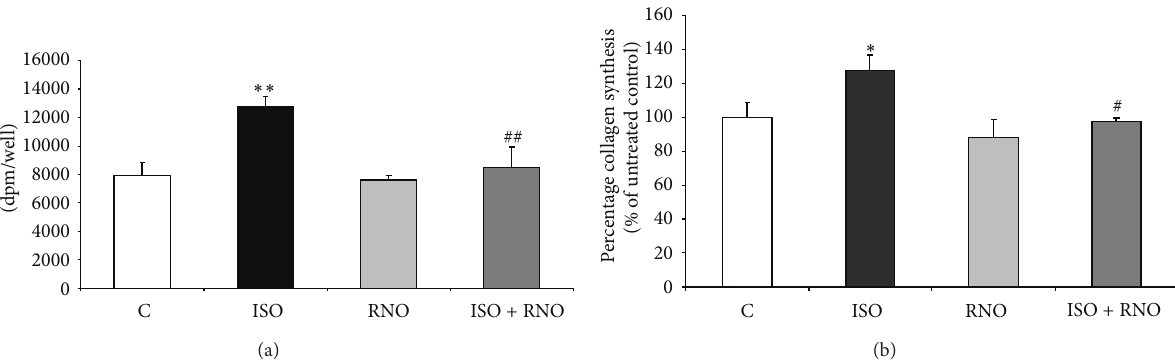
Figure 8: Effect of 8-epi-PGF 2𝛼 (ISO) and RNO on HLF proliferation and collagen synthesis. (a) Cells were preincubated for 30min in presence or absence of RNO (2nM) and then stimulated with 8-epi-PGF 2𝛼 (10 −8 M). Cell proliferation was evaluated after 24h by measuring [ 3 H]-thymidine incorporation in HLF. Results are expressed as [ 3 H]-thymidine incorporation (dpm) per well. Each sample was run in quadruplicate. Data are mean ± SD of 3 experiments. ∗∗ 𝑃 < 0.01 versus control (C); ## 𝑃 < 0.01 versus 8-epi-PGF 2𝛼 (ISO). (b) Media were harvested after 48 h of treatment for determination of [ 3 H]-proline incorporation into collagen and noncollagen proteins. Results (collagen/total protein) are presented as percentage of untreated control. Data are mean ± SD of 3 experiments. ∗ 𝑃 < 0.05 versus control (C); # 𝑃 < 0.05 versus 8-epi-PGF 2𝛼